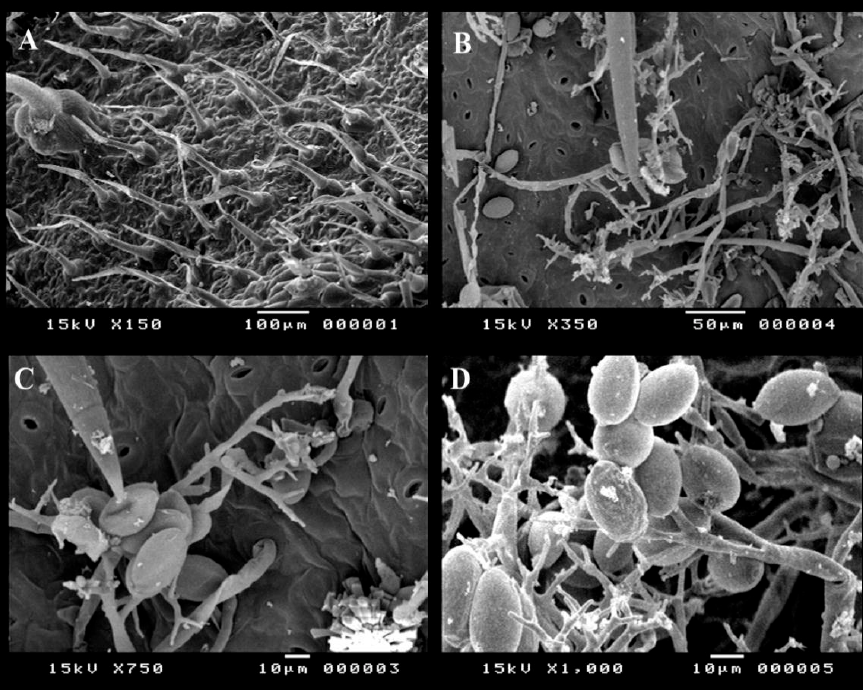
Figure 2. Scanning electron microscopy (SEM) of healthy and infected tomato leaf surfaces;